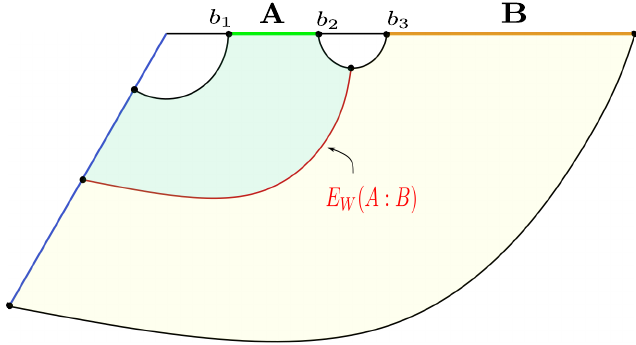
Figure 8. Schematics of the bulk entanglement wedge corresponding to the mixed state configu- ration of the two disjoint intervals in the dual moving mirror BCFT. Figure modified from [54].